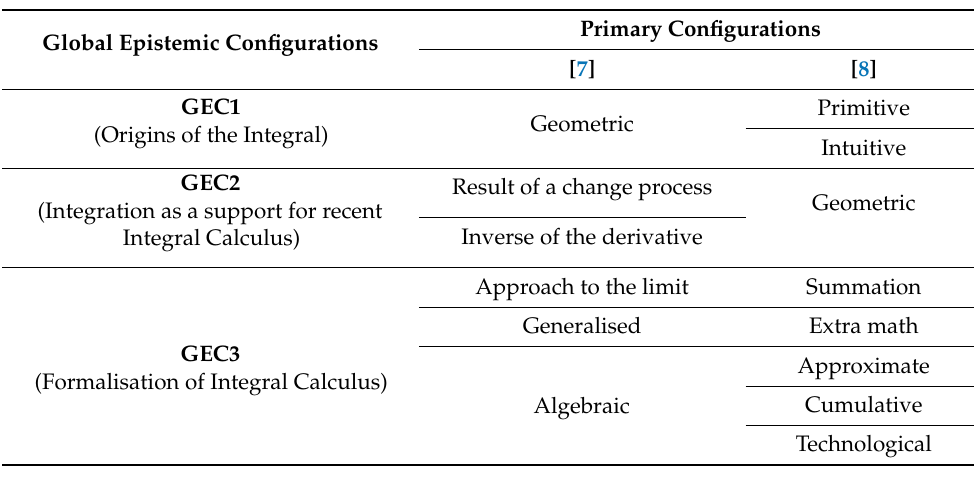
Table 1. Global complexity for the